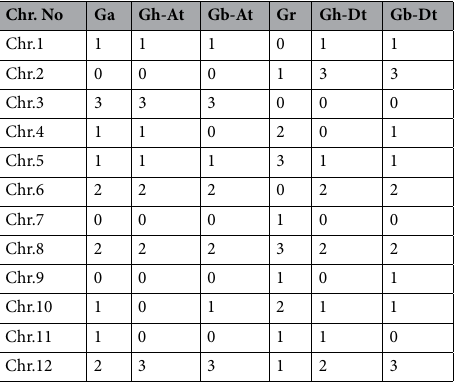
Table 2. Chromosome number distribution map of IFR genes in four Gossypium